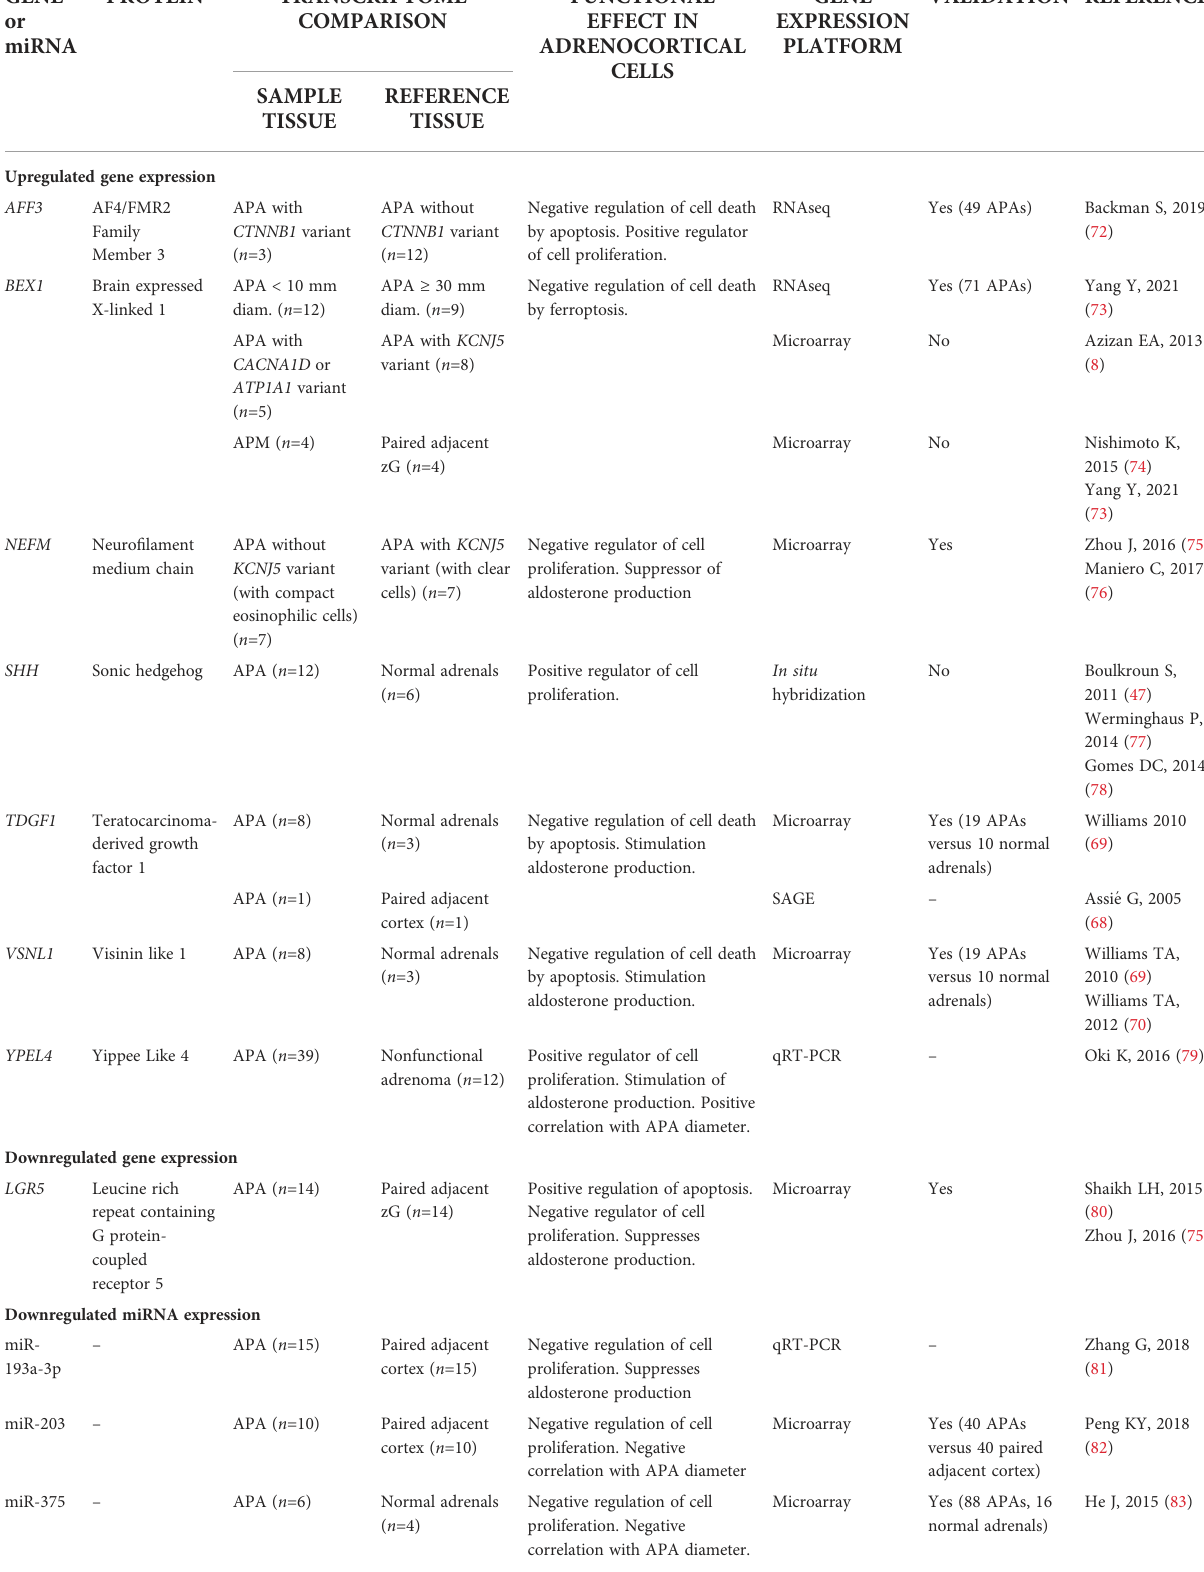
TABLE 2 Potential function of differentially expressed genes and Mirnas in Aldosterone-Producing Lesions. GENE or